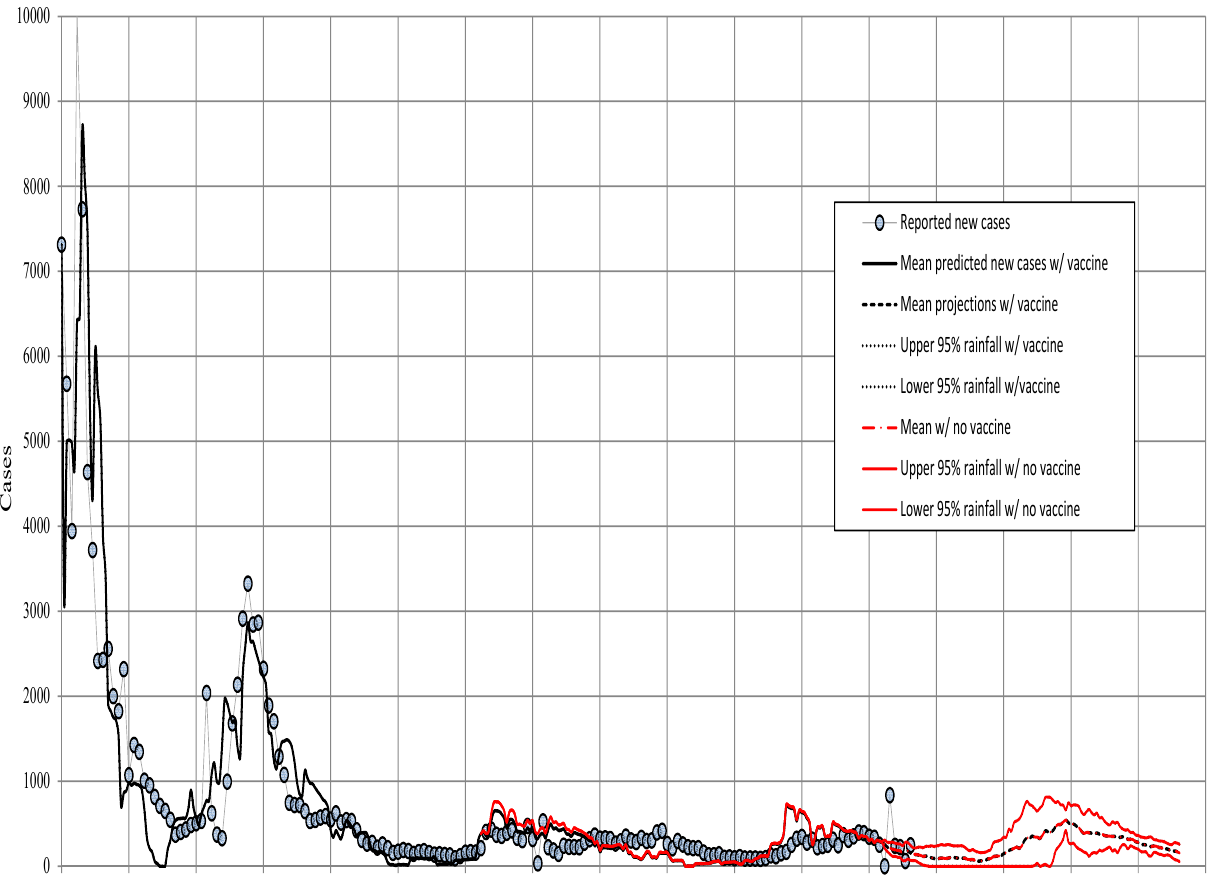
Figure 4. Artibonite. The new symptomatic individuals vs . time. Circles, observed; solid line, model prediction; dashed lines, 95th percentile confidence intervals for model projections. The red line is projections with 75 percent vaccine efficacy. Predicted and Reported Number of New Cases per Week vs Time Artibonite (data from17 October 2010 to 3 November 2013 with projections to 7 December